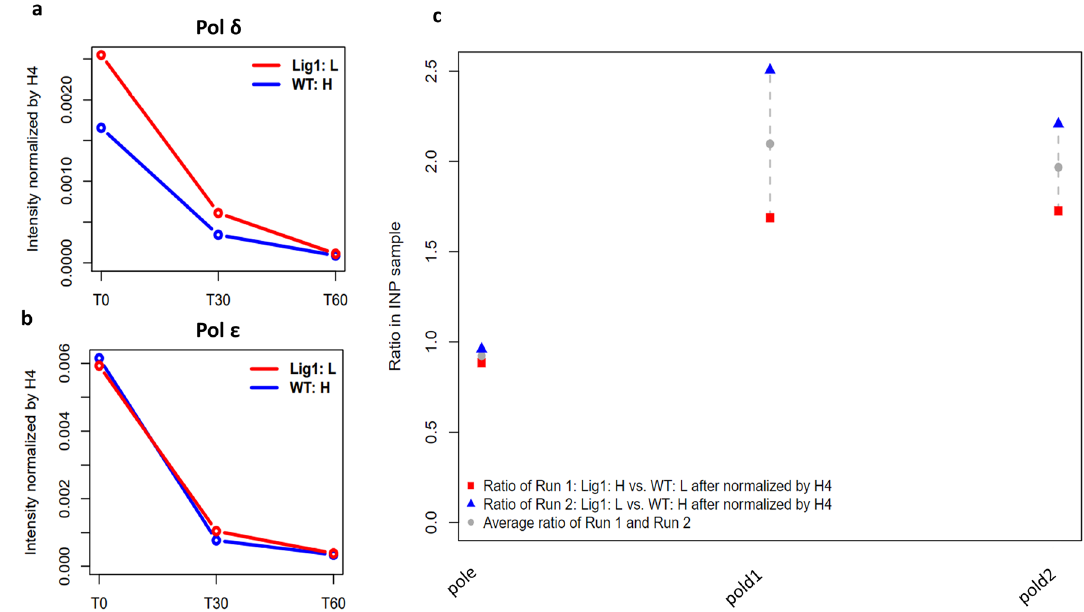
Figure 3. Increased association of DNA Pol δ with replicating DNA and chromatin in LIG1 null cells. The relative levels of; (a) Pol δ and (b) Pol ε associated with EdU-labeled DNA in CH12F3 wild type cells (WT:L, blue line) and a LIG1 null derivative (LigI:H, red line) were determined by mass spectrometry as described in Materials and Methods. ( c) The levels of Pol ε, Pol δ1, and Pol δ2 in the bulk chromatin are shown as a ratio of LIG1 null to WT cells in two independent experiments (red square and blue triangle) and their average (grey dot).